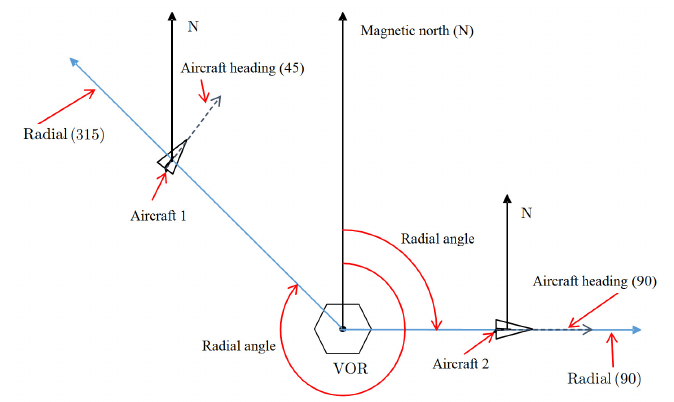
Figure 1. VOR radials and trajectory information obtained by planes receiving VOR signal.